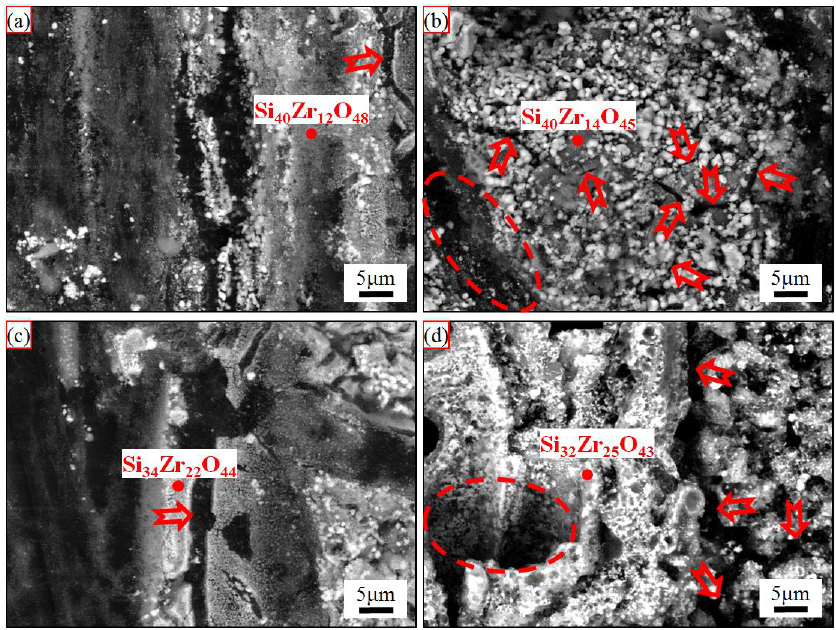
Figure 6. Surface morphologies of the ablated C/C-SiC-ZrC corresponding to the region I in Figure 3 and relevant EDS analysis: ( a , b ) under C 0.5 ; ( c , d ) under C 5 ; ( a , c ) non-woven layer; and ( b , d ) web